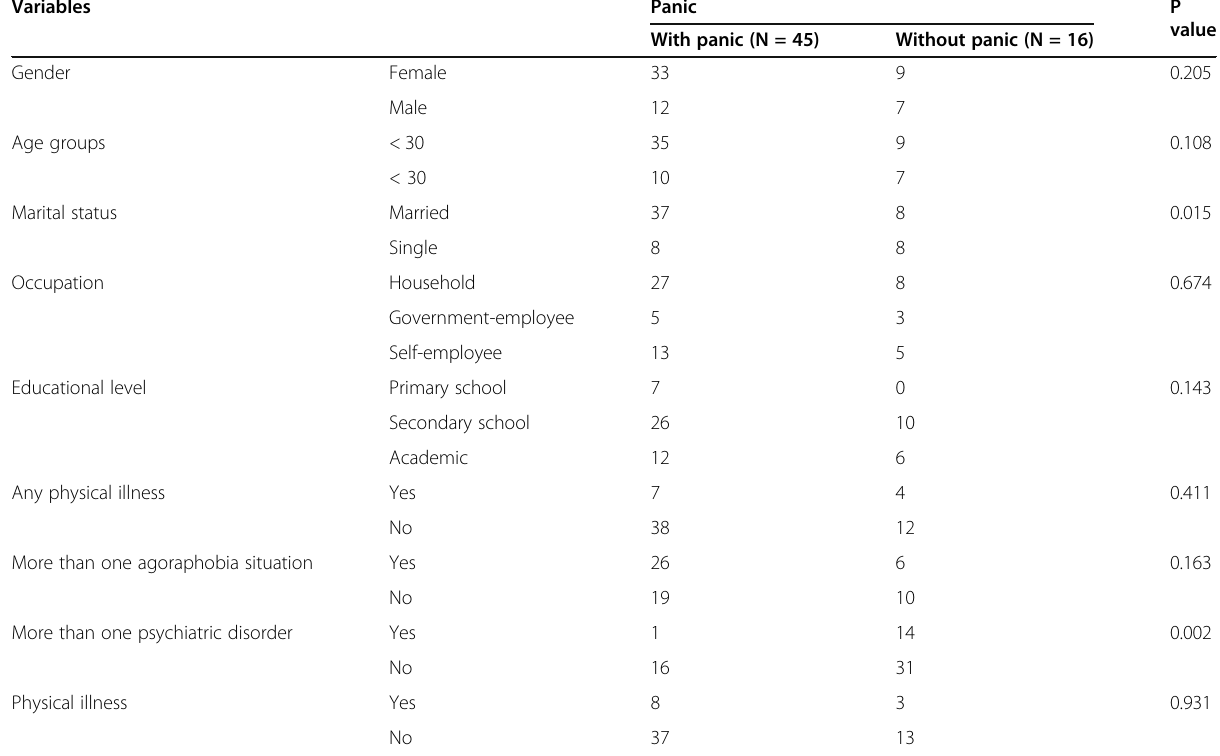
Table 2 Association between demographic characteristics and panic disorder Variables Panic P